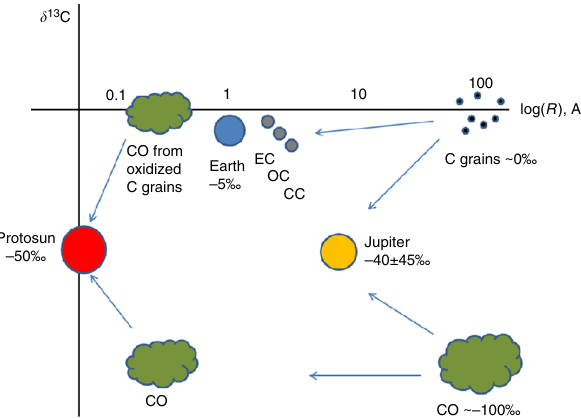
Fig. 9 Illustration of one possible explanation for the difference between solar and terrestrial planet and asteroidal C isotopes. If, in the parent molecular cloud, carbonaceous grains have a δ 13 C PDB values ~0 ‰ and CO has δ 13 C PDB ~ − 100 ‰ , and C is approximately equally distributed between grains and CO gas, then formation of Jupiter from both grains and gas would yield δ 13 C ~ − 50 ‰ . Terrestrial planets and asteroids, formed primarily from planetesimals with C from C grains, would have δ 13 C ~0 ‰ . If C grains were converted to CO gas in the hot, inner solar nebula 69 , the total accreted CO gas would yield a solar δ 13 C ~ − 50 ‰ , as reported here. The cause of the C isotopic ratio difference in grains and dust of the parent cloud may have been a result of self-shielding in the parent cloud exposed to a high FUV radiation fi eld, as, e.g., observed in Ophiucus